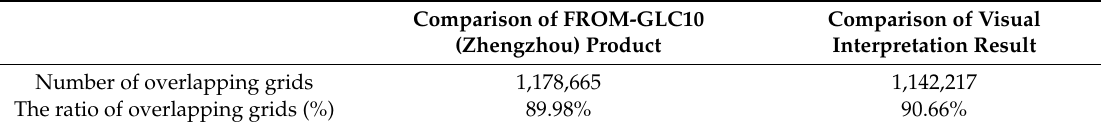
Table 5. Comparison of some products in position over